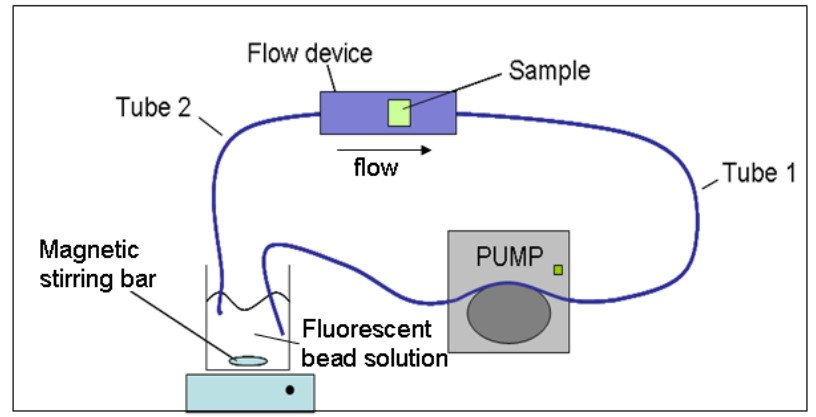
Figure 2. Experimental setup for perfusion